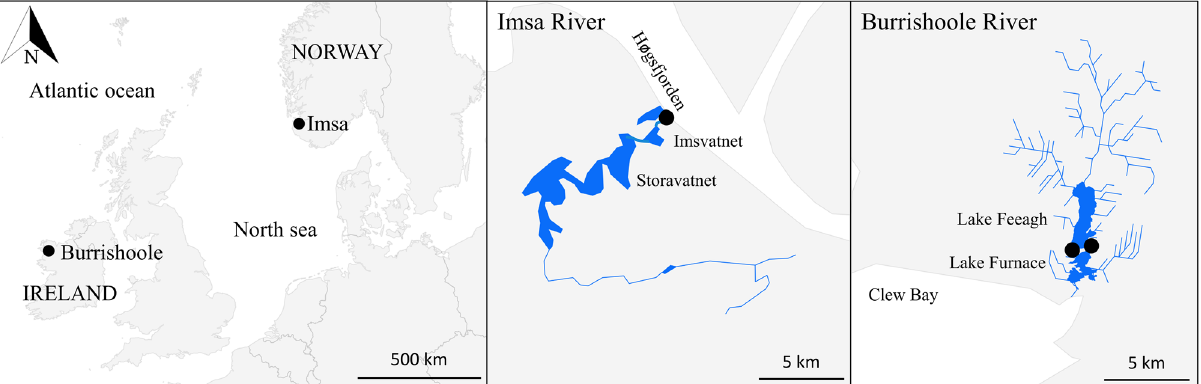
Figure 1. Location of the monitoring stations ( on the Imsa River in Norway and on the Burrishoole River in